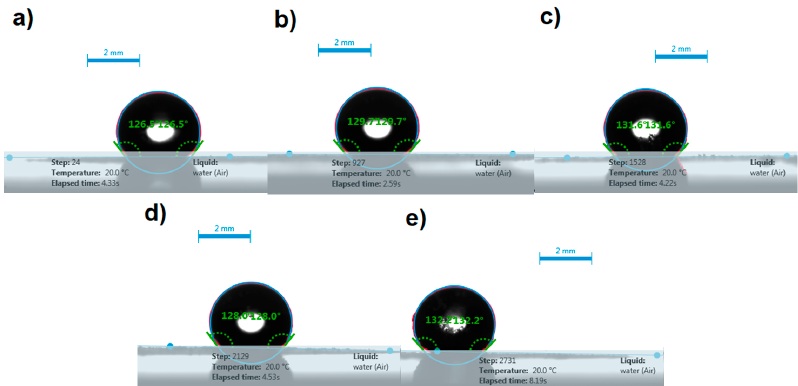
Figure 10. Representative images of water droplets on the surface of disks and contact angles of: ( a ) crystalline ITR, ( b ) freeze dried ITR (FD ITR), ( c ) the ITR–OXA cocrystal, ( d ), the ITR–SUC cocrystal and ( e ) the ITR–TER cocrystal.